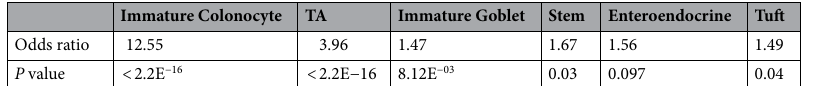
Immature Colonocyte